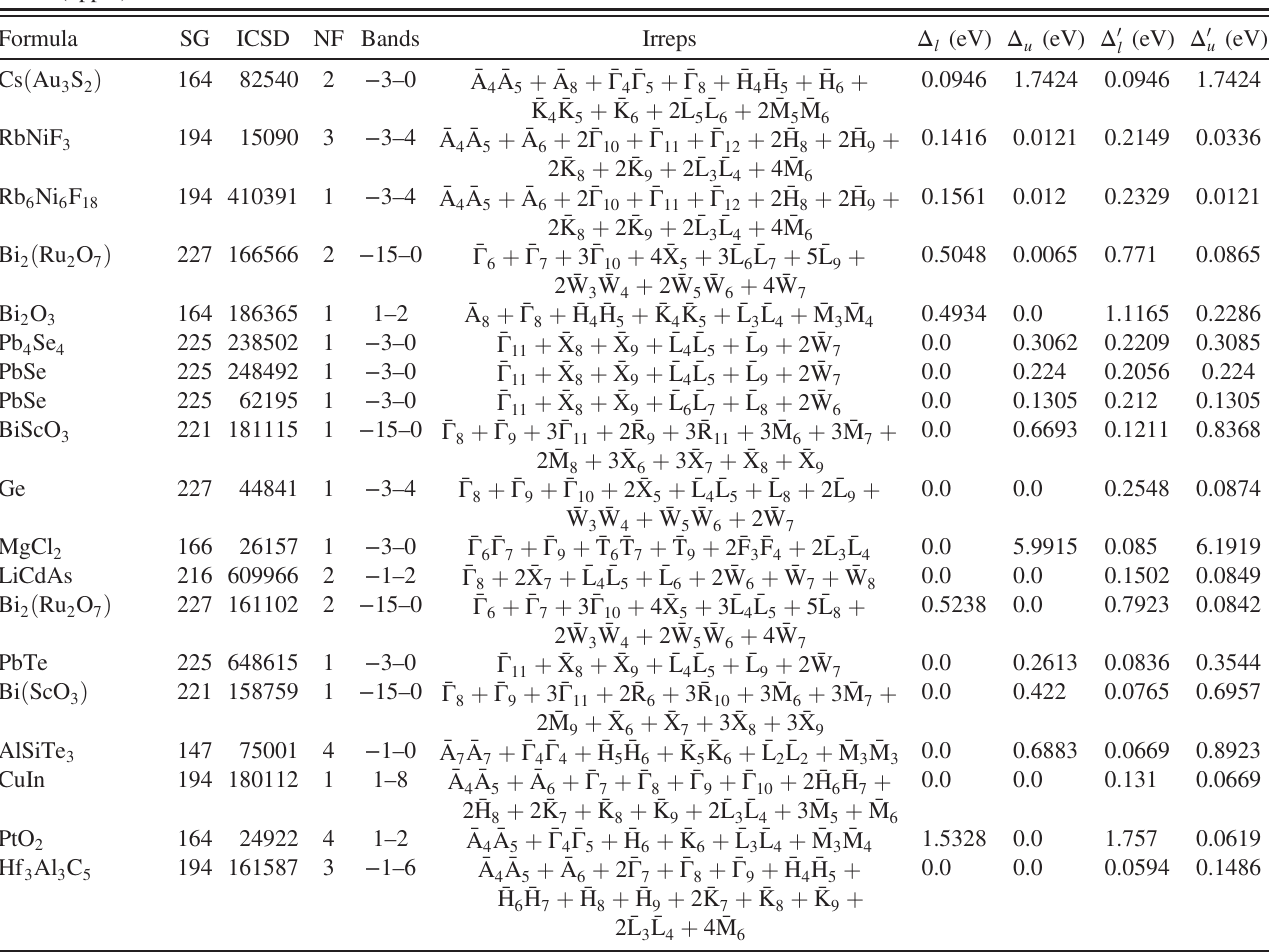
TABLE III. Fragile bands in materials. In the first three columns, we tabulate the chemical formulas, the space group numbers, and the ICSD numbers of the materials. The fourth column gives the number of fragile branches in the band structure of the corresponding material. In the fifth to tenth columns, the information of the fragile branch closest to the Fermi level is tabulated. The column “ Bands ” gives the band indices of the fragile branch. Here, we refer to the highest occupied band as the zeroth band and the lowest empty band as the first band, etc. The column “ Irreps ” gives the irreps formed by the fragile bands at high symmetry momenta. The column Δ the indirect gap between the fragile bands and the lower (upper) bands, and Δ 0 lower (upper)